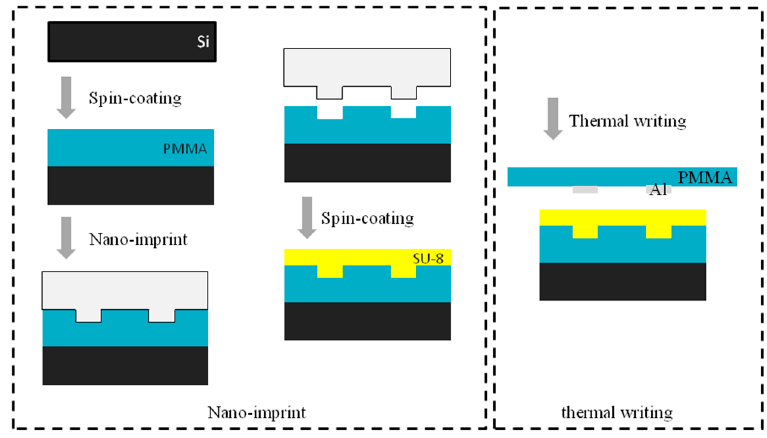
Figure 5. Fabrication process of the waveguide by nanoimprint and schematic diagram of thermal writing.